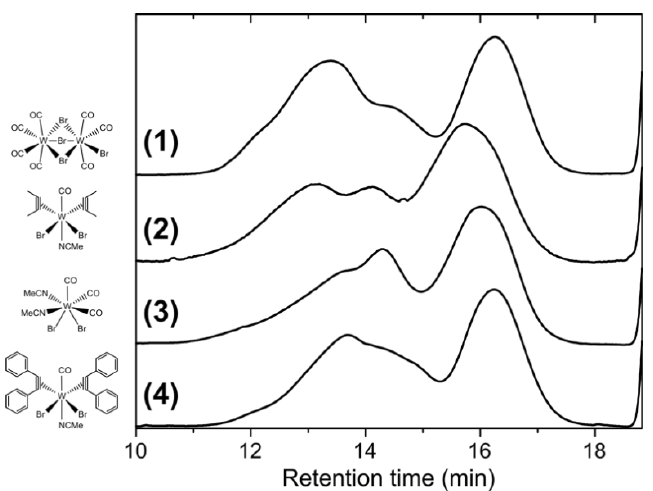
Figure 2. Comparison of the gel permeation chromatograms of PPMs synthesized with the catalysts ( 1 ) – ( 4 ), indicated with their chemical structures.